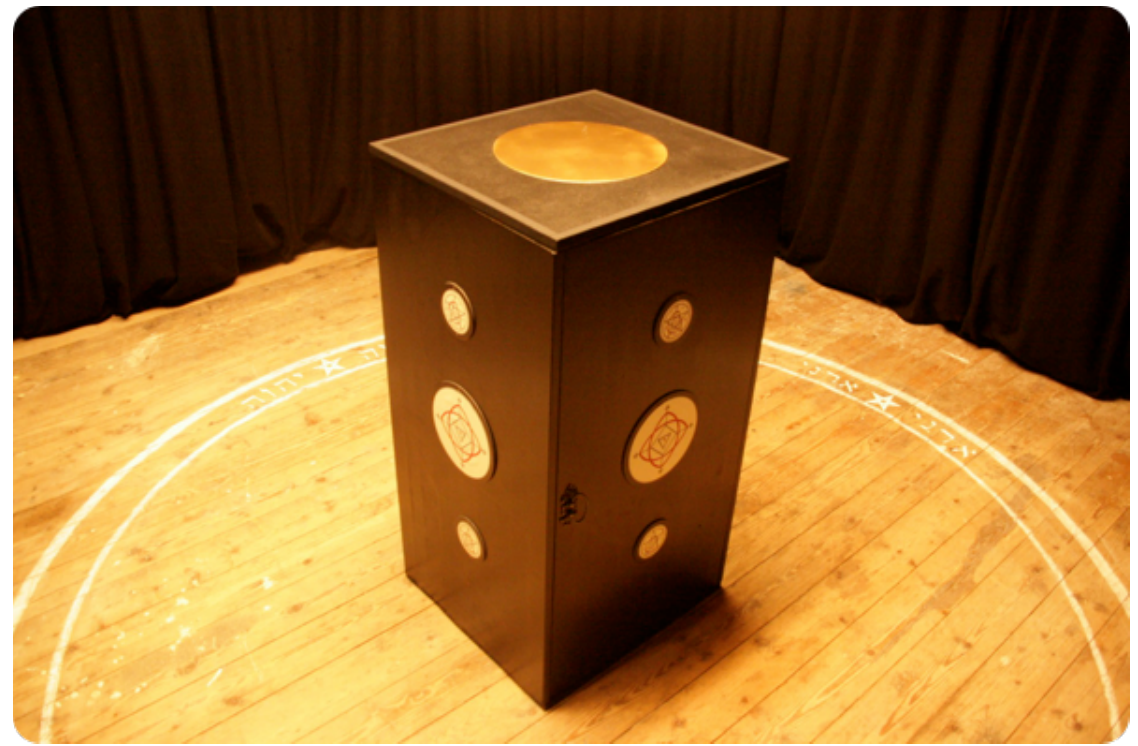
Figure 2 The ritual chamber with Frater Acher’s altar, © Frater